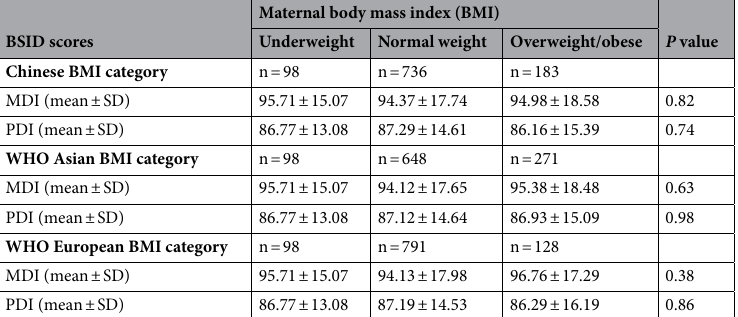
Table 3. Bayley scores compared among the four BMI groups based on the Chinese, WHO Asian or WHO European BMI classifications. Values are mean ± SD.